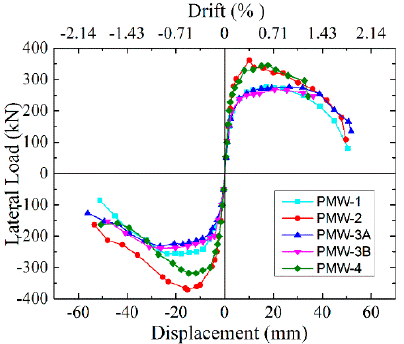
Figure 9. Envelope curves of the test walls.